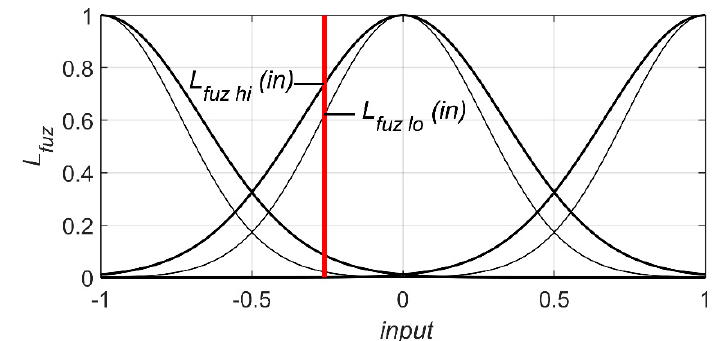
Figure 3. Type-II fuzzy membership functions.